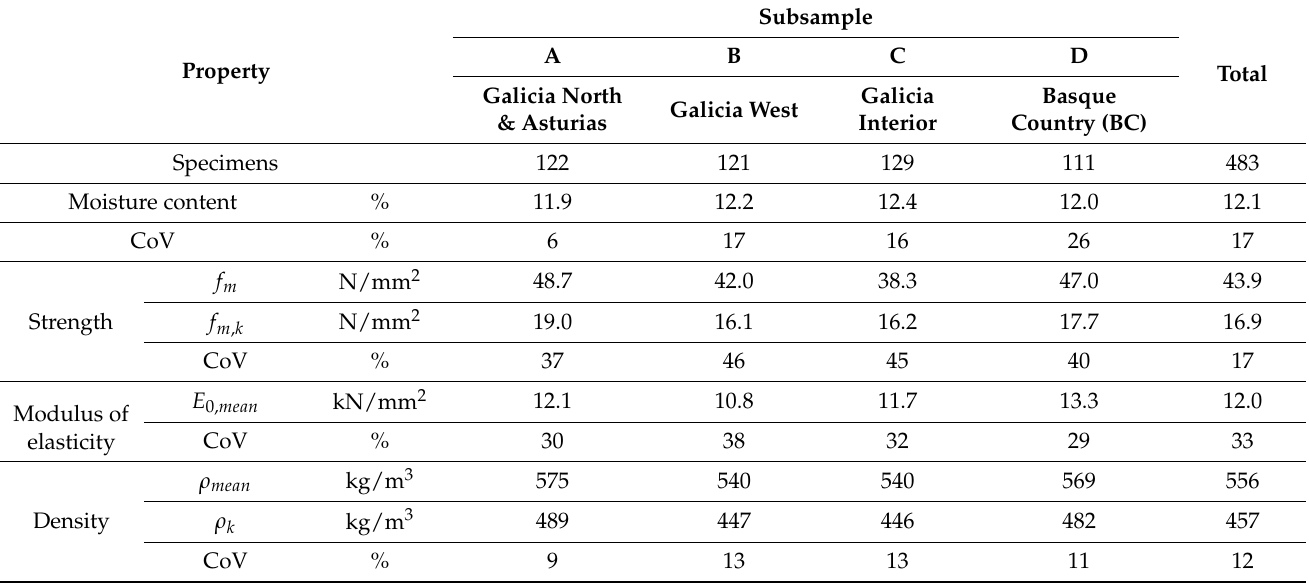
Table 2. Characteristic values of the mechanical and physical properties of maritime pine.